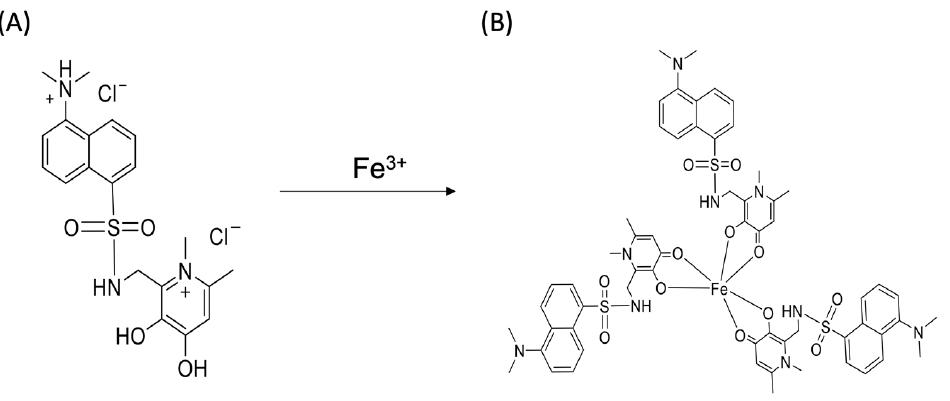
Figure 1. Chemical formula and structure of D-3,4-HPO ligand ( A ) and the formula and structure of the corresponding tris(3-hydroxy-4-pyridinonato)Fe(III) complex that is formed ( B ).